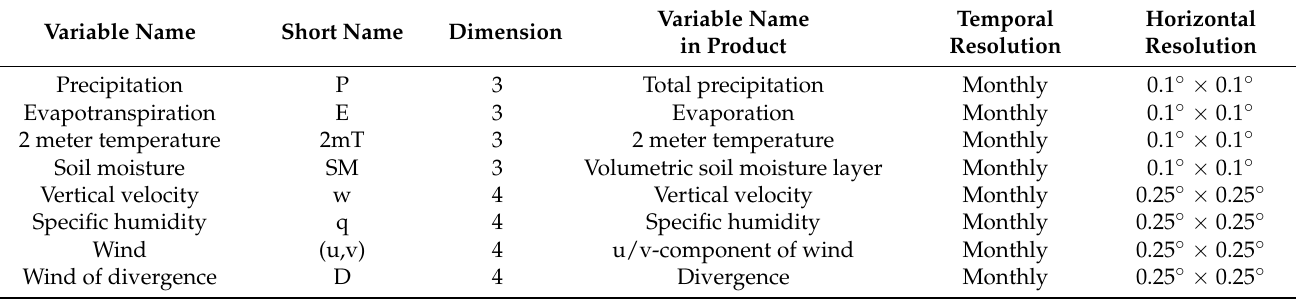
Figure 1. Location of the study area and multi-year average E/P (degree of dryness) of the IMYRB. (blue for the eastern extent of the IMYRB and green for the western extent of the IMYRB). Table 1. The reanalysis data used in this study.